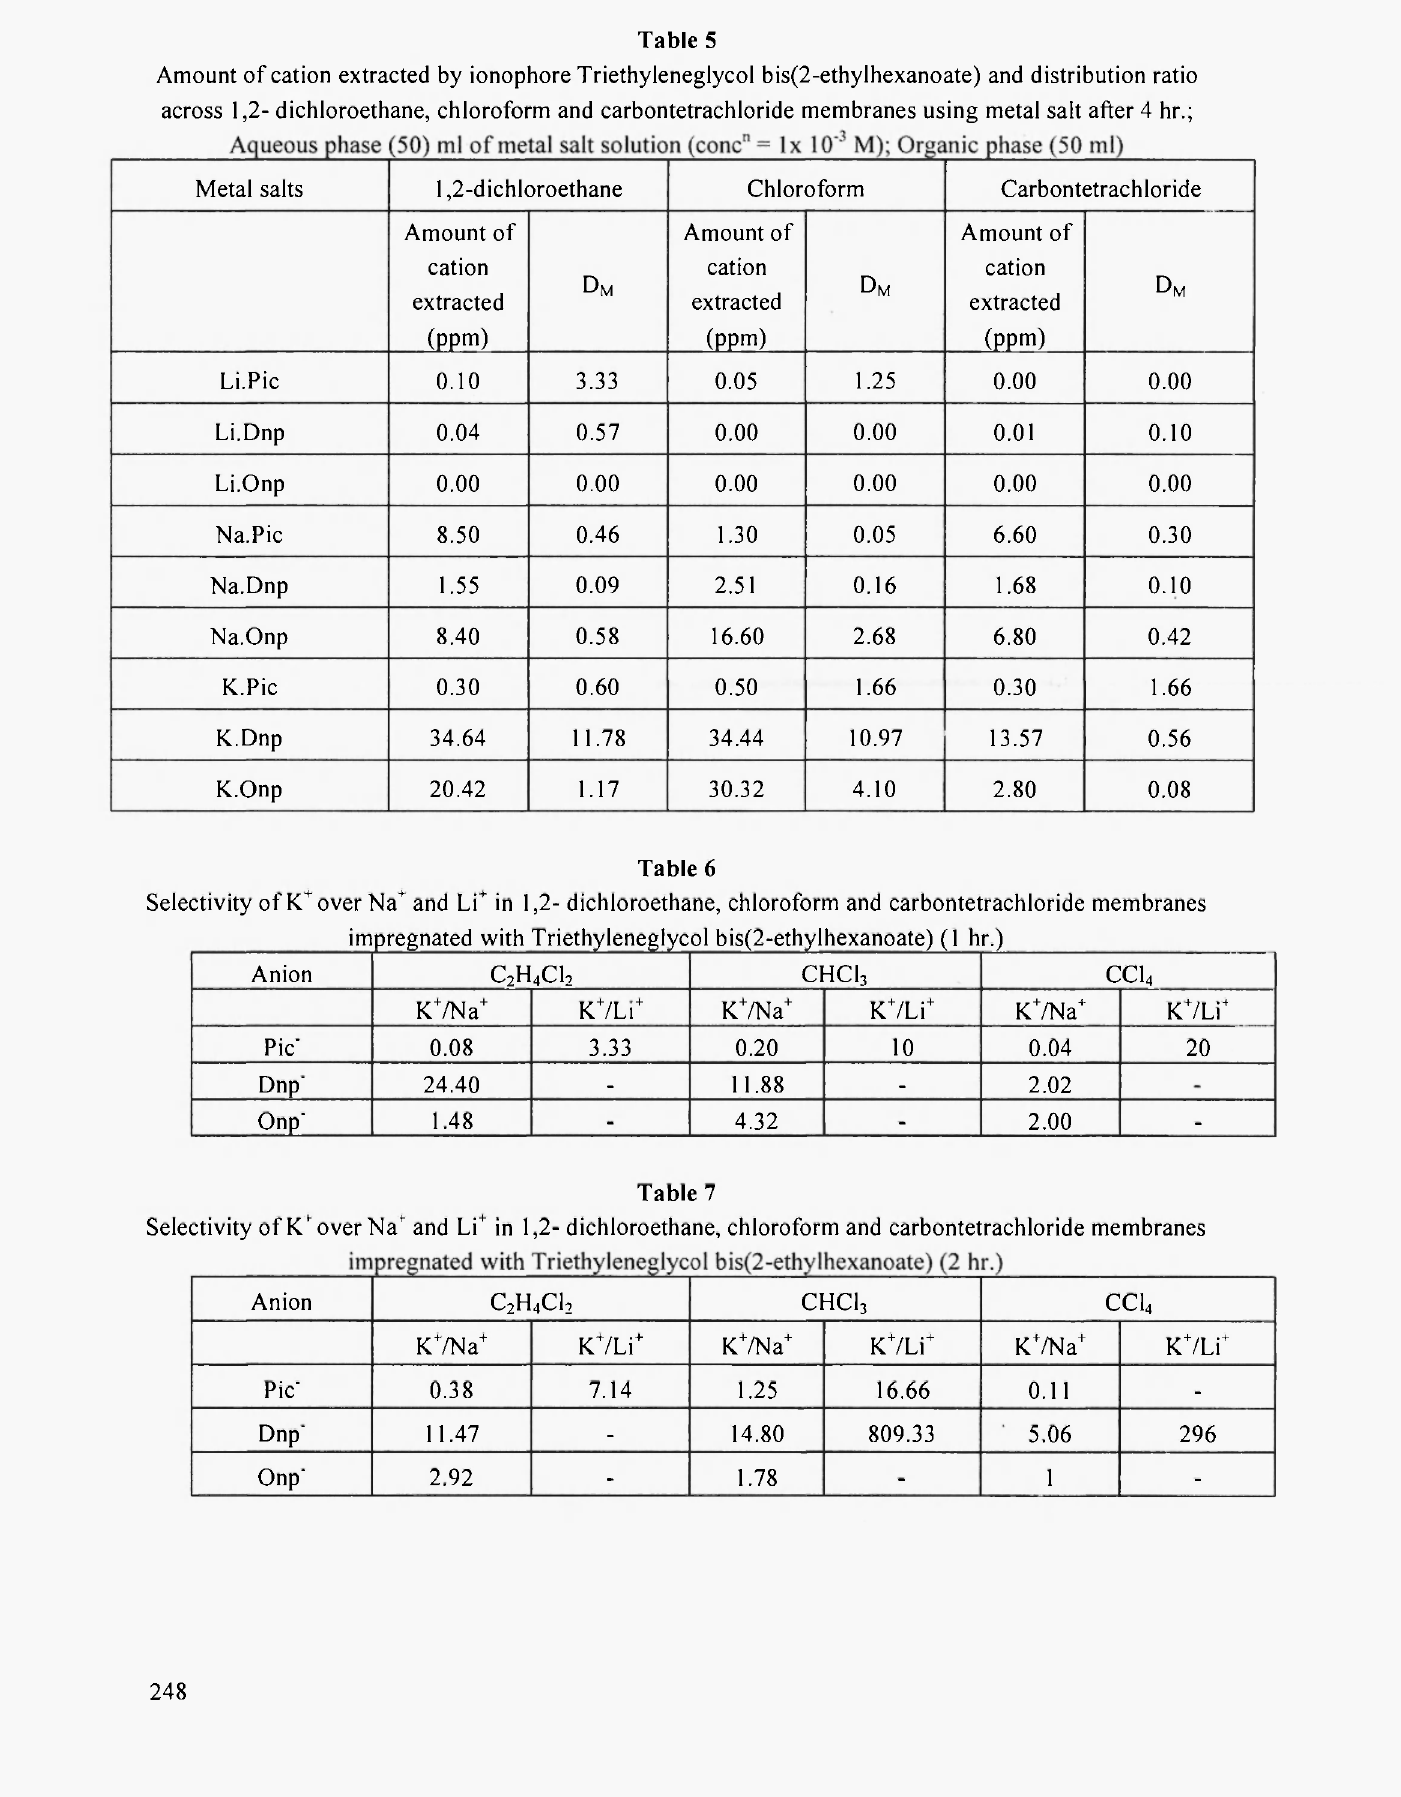
Selectivity of K'overNa*^ and Li + in 1,2- dichloroethane, chloroform and carbontetrachloride